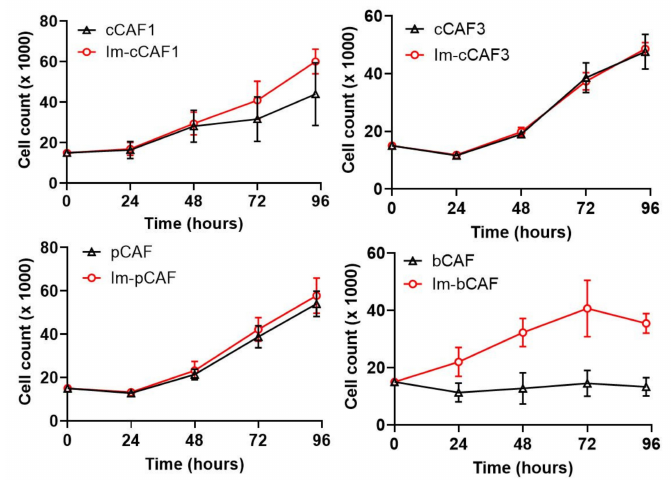
Figure 3. Growth assay of primary CAFs and immortalized (Im-)CAFs. 15.0 × 10 3 cells of the indicated Im-CAF (passage 4) or primary (passage 3) cell lines were plated and then harvested at the indicated time points. The line graph depicts the mean ± SD of 6 replicates from 2 independent ex- periments.